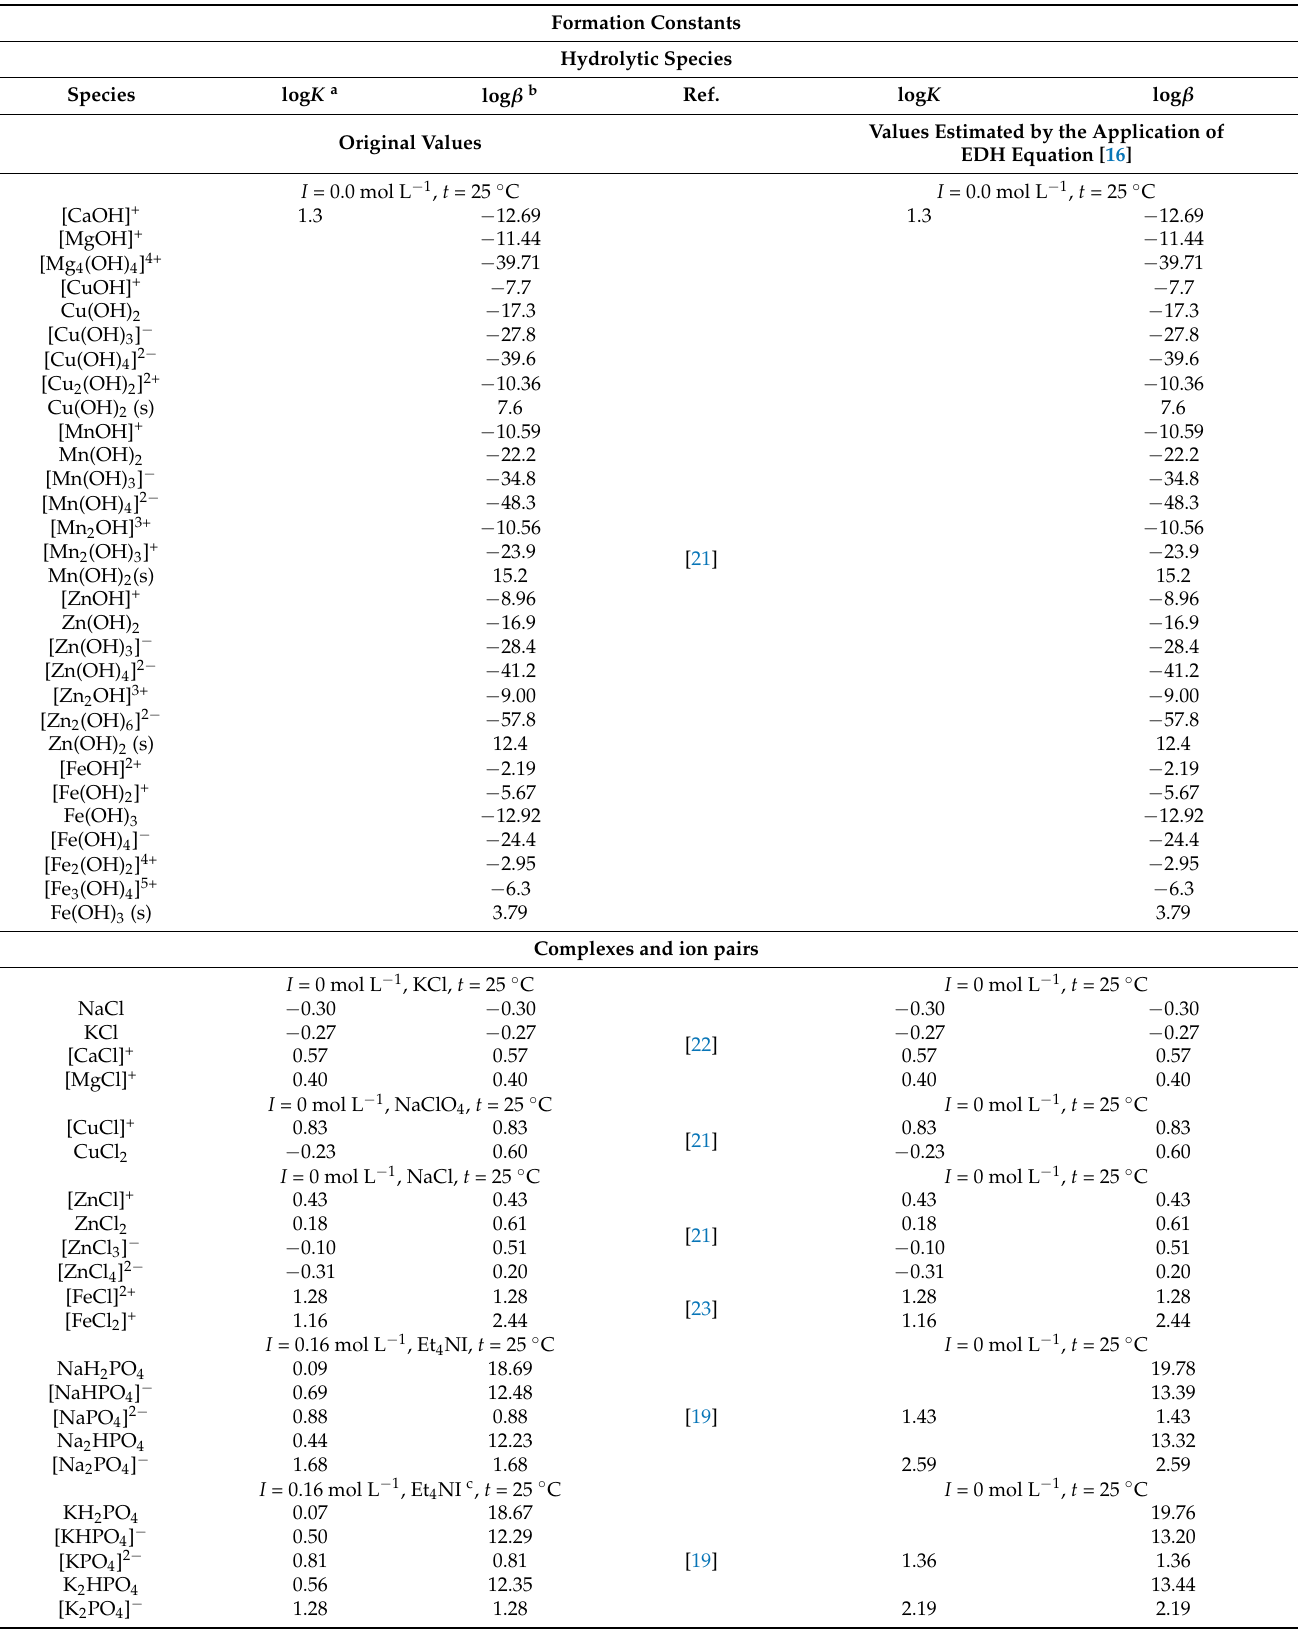
Table 3. Overall (log β ) and partial (log K ) formation constants of the species considered in the model. Formation